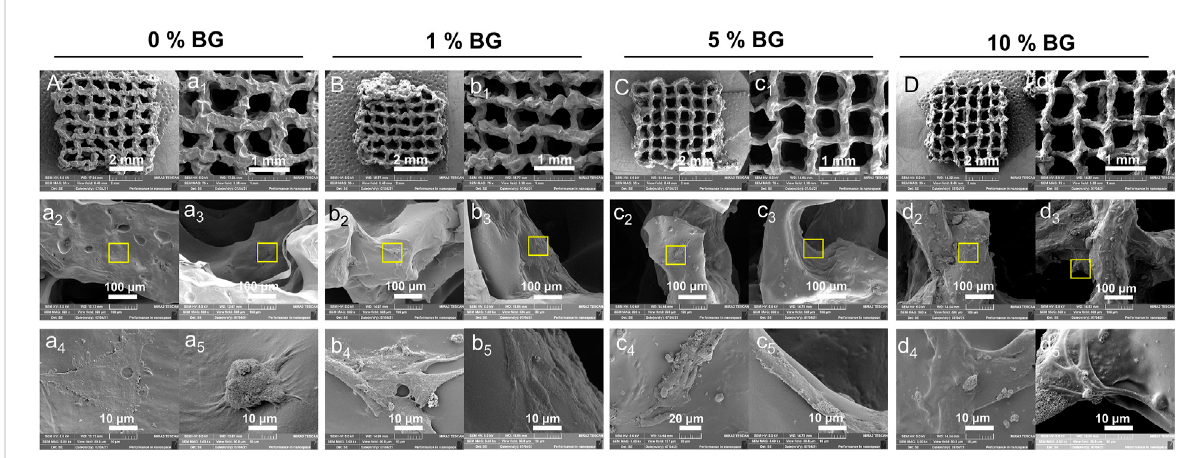
FIGURE 6 Cell morphology of HPDLCs in 3D-printed biomimetic BG/GelMA macropore scaffolds by SEM. Cells were cultured in scaffolds 0% BG, 1% BG, 5% BG, and 10% BG for 24 h (A,B,C, and D) SEM images of integral scaffolds with cells from scaffolds 0% BG, 1% BG, 5% BG, and 10% BG at 30x magni fi cation. (a 1 , b 1 , c 1 , and d 1 )SEM images of partial scaffoldswith cells from all groups at75x magni fi cation. (a 2 , b 2 , c 2 , and d 2 )SEM imagesof cells in the outer surface and (a 3 , b 3, c 3 , and d 3 ) inner pore surface of scaffolds at 500x magni fi cation. (a 4-5 , b 4-5 , c 4-5 , and d 4-5 ) Magnifying images of cells of the yellow box area at 5.0kx magni fi cation. A/a 1 -a 5 ) 0%BG group; B/b 1 -b 5 )1% BG group; C/c 1 -c 5 )5% BG group; and D/d 1 -d 5 ) 10% BG group.